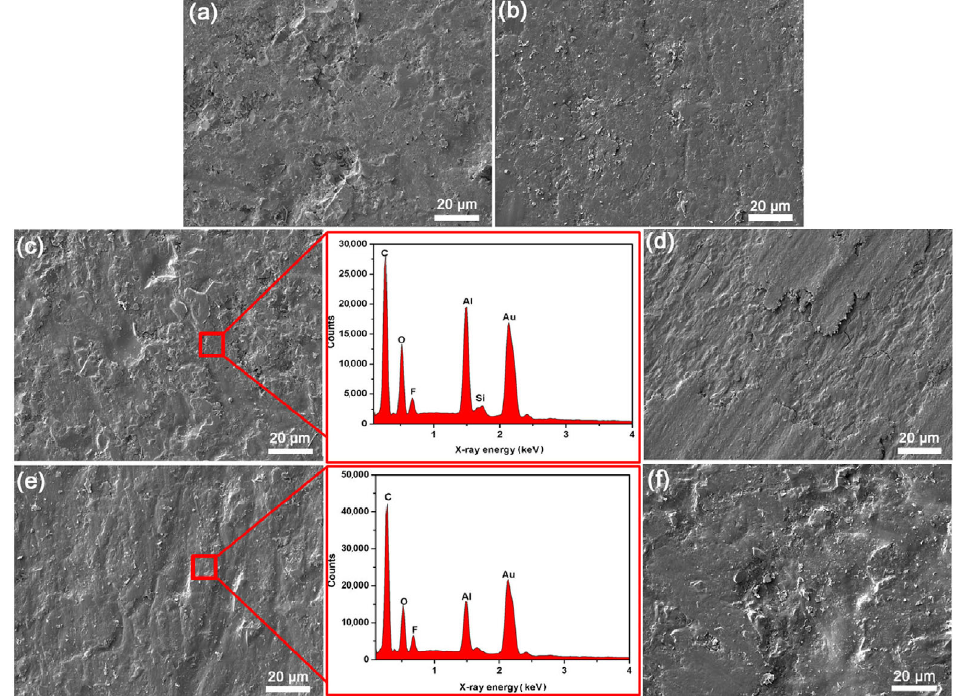
Fig. 8 Tribofilms on Al 2 O 3 surface after rubbing with (a, b) PI/AP, (c, d) PI/AP/SiO 2 , and (e, f) PI/AP/BN at 4 and 8 MPa·1m/s. The EDS analysis of the red squares in (c) and (e) are shown on the